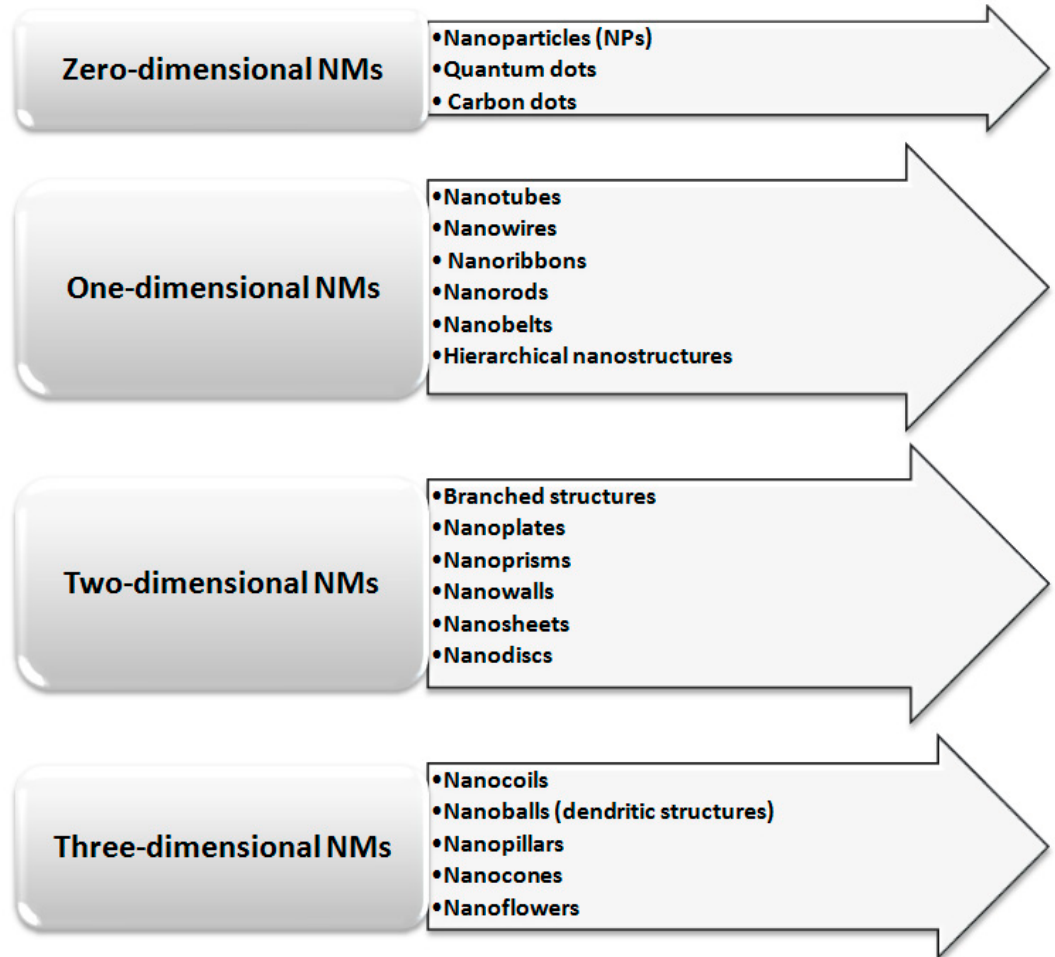
Figure 1. Classification of nanomaterials based on the dimensionality of materials. Table 1. Information on NMs classified in different classes.